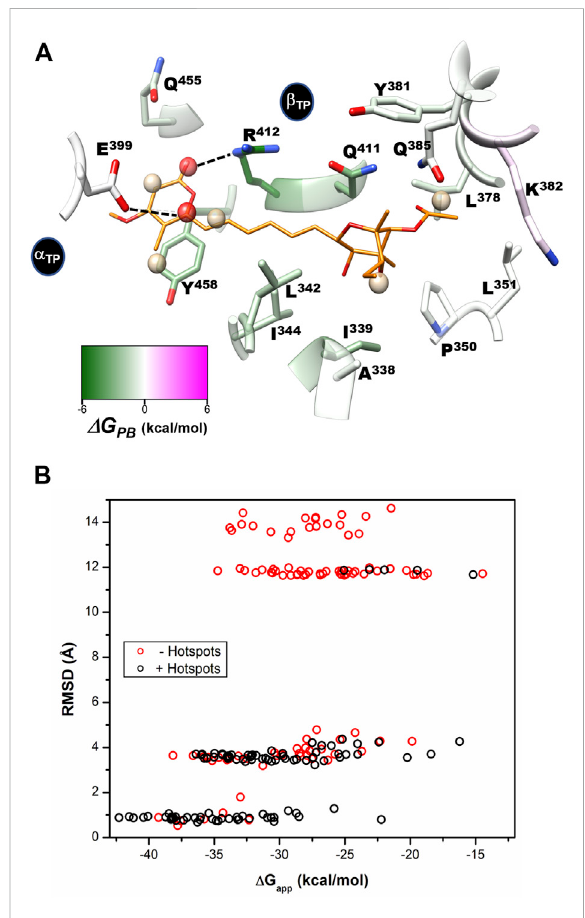
FIGURE 8 Per-residue free energy decomposition, solvent site identi fi cation, and guided docking. (A) Per-residue decomposition of the binding free energy ( Δ G PB ) calculated with the MMPBSA method. Residues that favor interaction with the inhibitor are shown in green. Identi fi ed hydrophobic (SS HP ) and hydrophilic (SS POL )solventsitesareshownastanandredspheres,respectively. The fi ve SS HP overlapped with AUR apolar carbons, while one SS POL reproduces the polar-to-polar interaction between β R 412 and AUR O19. The other detected SS POL , which interacts with α E 399 , does not have an equivalent interaction with AUR. CHEWD was used to generate the image (Raza et al., 2019). (B) AUR- docking score ( Δ G app )obtained with rDock guided (black symbols) and not guided (red symbols) with solvent sites (hot spots) as pharmacophores. 100 docking runs were carried out for each instance. RMSD of each docked pose was calculated against the crystallographic pose of the